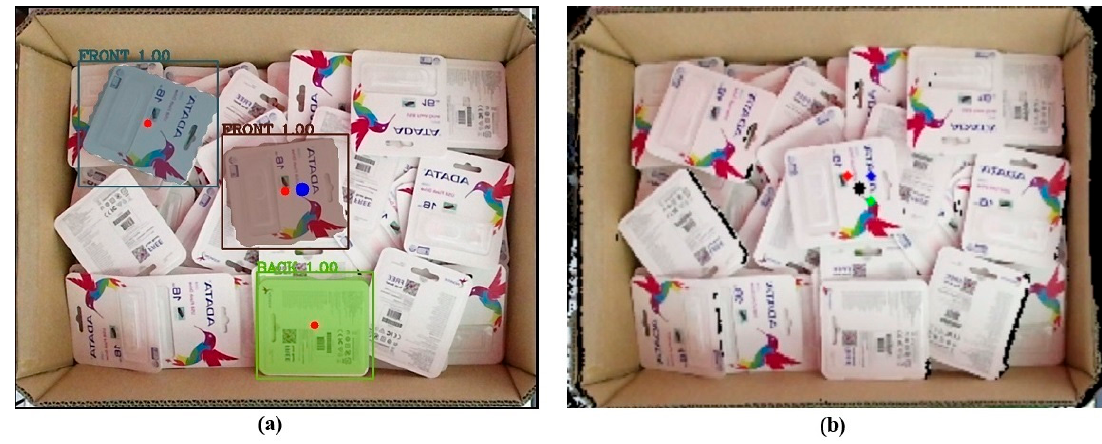
Figure 27. ( a ) Final target as the blue point, and ( b ) mapping result as the black point.